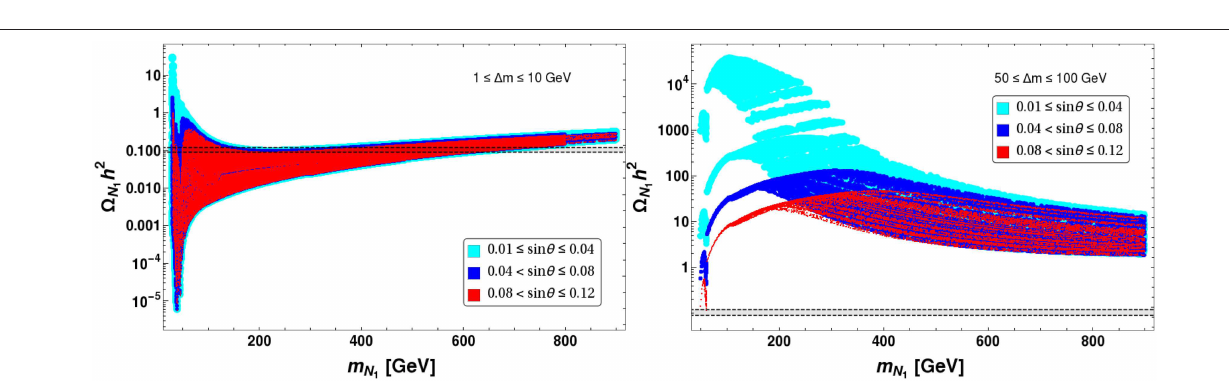
sin θ keeping fixed range of sin θ : 0.01 0.05 (left panel) and 0.08 1 ≤ ≤ 1 m (inGeV) 10 (Orange), 10 < 1 m (inGeV) 30 (Blue), 30 < 1 m (inGeV) ≤ ≤ ≤ (cid:127) h 2 0.1206 is shown by black dashed line. All the masses are in GeVs. ≤ ≤